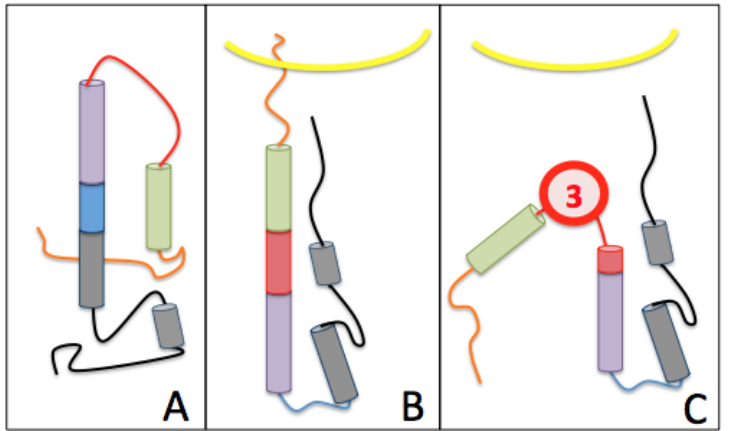
Figure 6. Proposed model of fusion disruption by a small molecule docked on target 3. Only the HA2 polypeptide is shown for clarity. It consists of 6 distinct parts: the fusion peptide located at the extremity of the polypeptide N-terminus is orange, followed by zone A in the helix (in green), loop B is in red, zone C in the helix is in purple, the kink in blue and zone D in black at the C-terminal